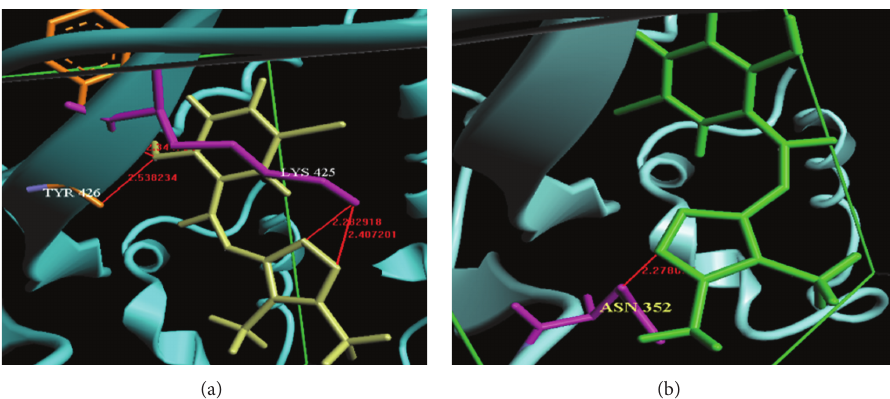
Figure 3: (a) Interactions between TYR and LYS-DMIIMBP crystal ligand (yellow) and target protein (pale green). The TYR residue (gray) and LYS residue (pink) interactions are shown in CPK model. Hydrogen bonding interactions were represented as line (red). (b) Interactions betweenASN-DMIIMCPcrystalligand(green)andtargetprotein(palegreen).TheASNresidue(pink)interactionsareshowninCPKmodel. Hydrogen bonding interactions were represented as line (red).